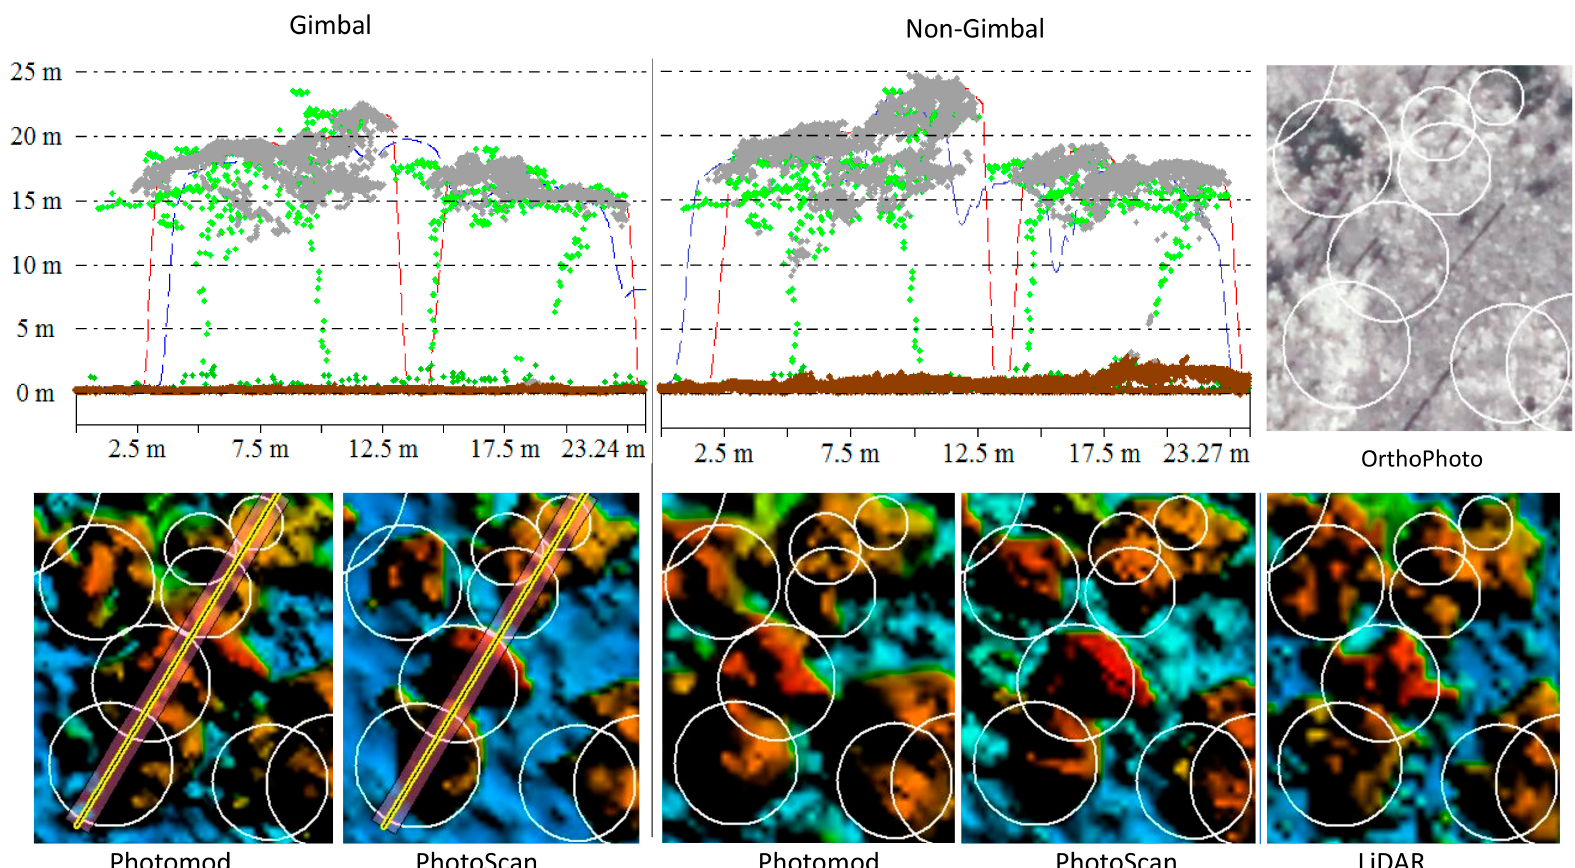
Figure 6. Horizontal transect (1.6 m wide) of study area subset. Reference LiDAR three-dimensional (3D) point cloud (green dots), PhotoScan extracted point cloud (grey dots—vegetation; brown dots—classified terrain), Photomod digital surface model (DSM) (blue line), PhotoScan DSM (red line), and their corresponding 40 cm raster DSMs used for local maxima and watershed segmentation.